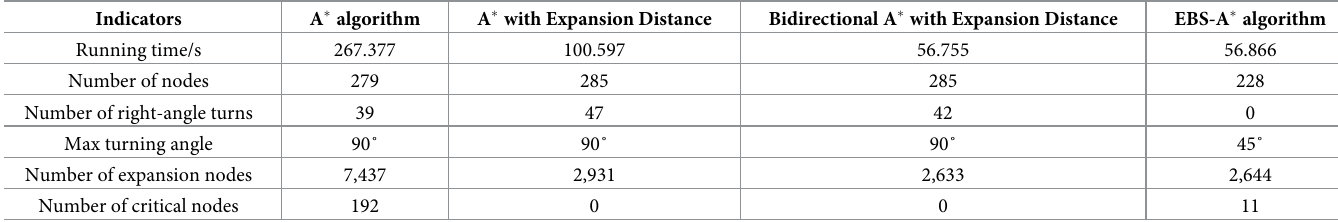
Table 5. Simulation results of four algorithms on a 150 × 150 map.